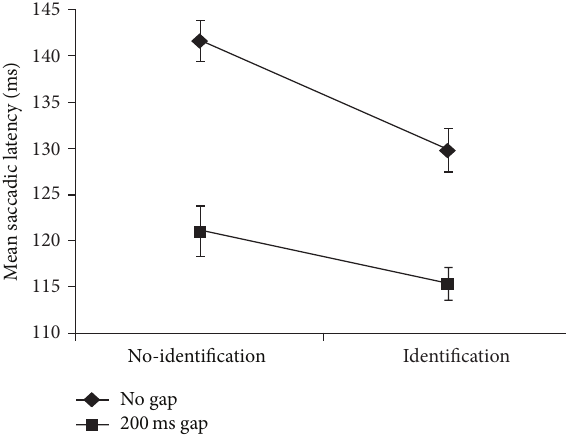
Figure 3: Significant two-way interaction of gap × identification of target feature for saccadic latency. Error bars = ± 1 SEM.